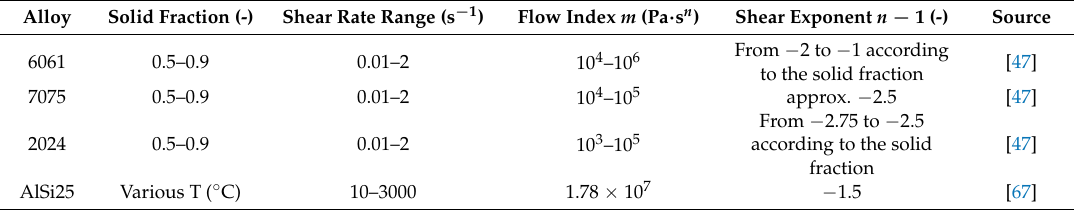
Table 2. Power law parameters from compression experiments for different